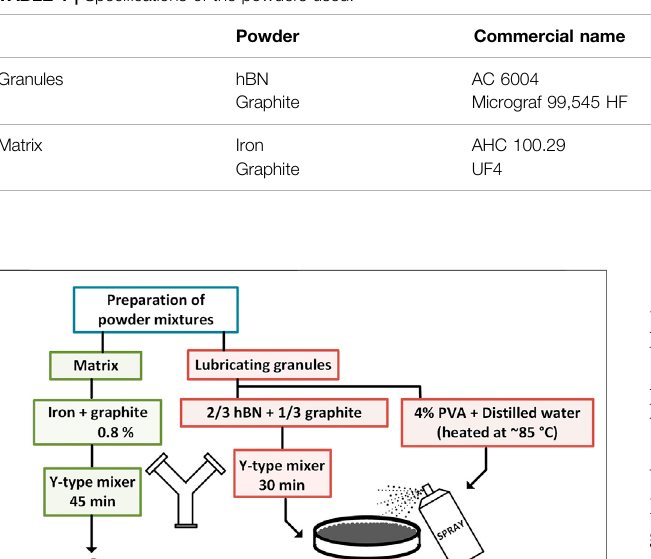
TABLE 1 | Speci fi cations of the powders used.